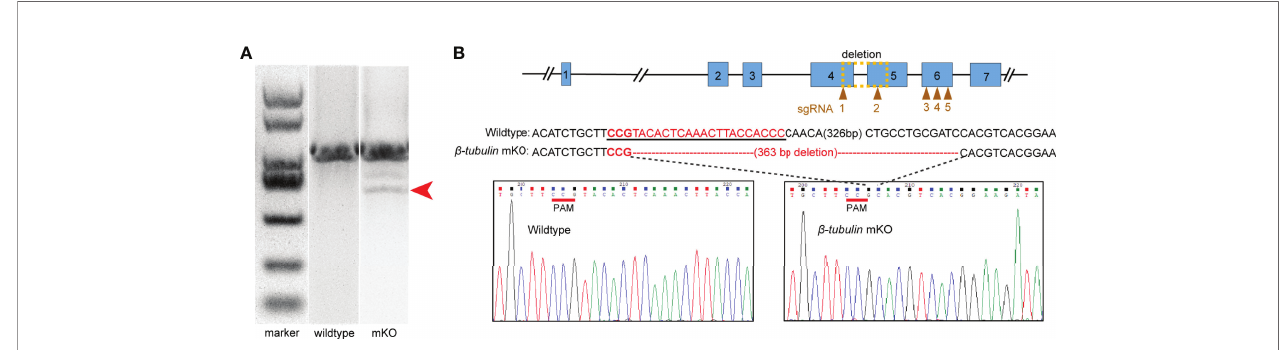
FIGURE 4 | Characterization of deleted mutations in the electroporated embryos. Embryos electroporated with Cas9-sgRNA complex were sacri fi ced for PCR and sequencing. (A) Fragment sizes analysis by agarose gel electrophoresis. Mutant PCR bands were detected (red arrow). (B) DNA sequence analysis showed the presence of 363 bp deletion around the Cg b -tubulin -sgRNA-1 and Cg b -tubulin -sgRNA-2 (yellow dotted box); sgRNA sequences are shown in the black underline, PAM sequences are shown in red underline, and the deleted nucleotides are shown in short straight lines.